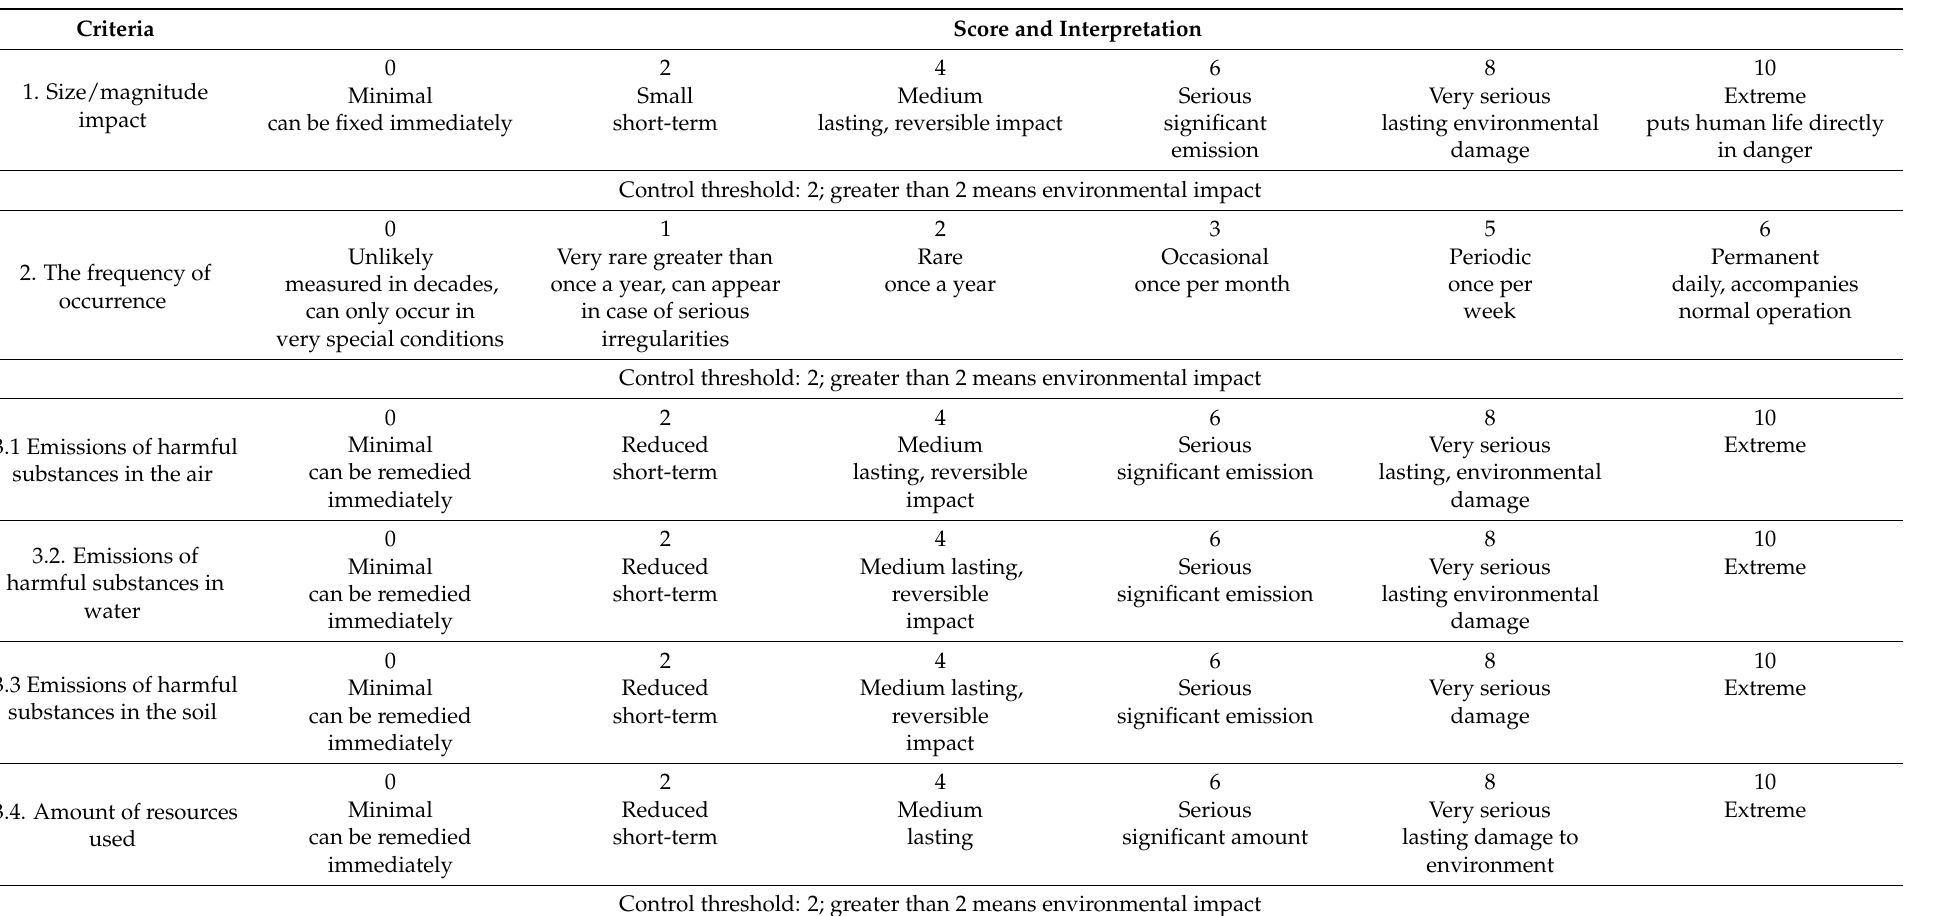
Table 1. List of centralized environmental aspects and significant environmental impact